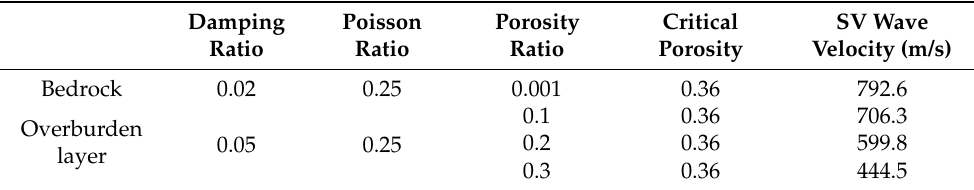
Table 3. Calculation parameters of saturated sedimentary